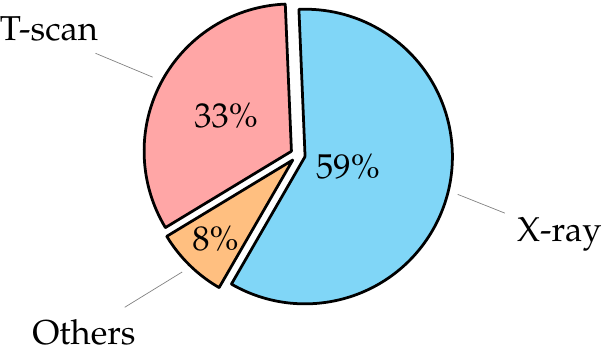
Figure 9. Image type of thoracic diseases distribution using deep learning in the recent years.